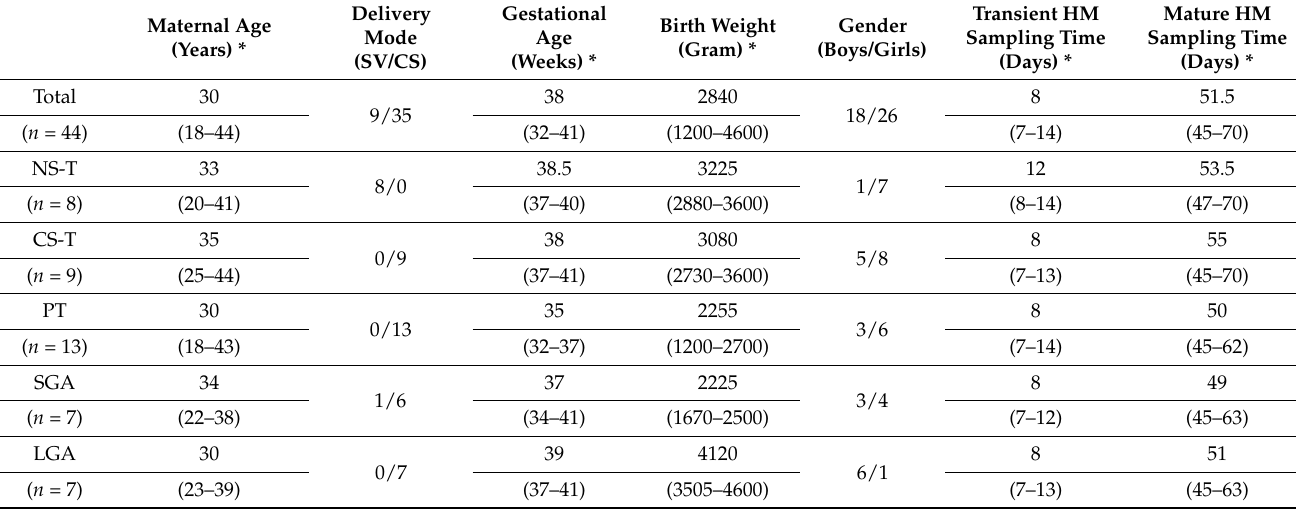
Table 1. Maternal age, mode of delivery, gestational age, birth weight, gender, and human milk sampling time of entire study group and